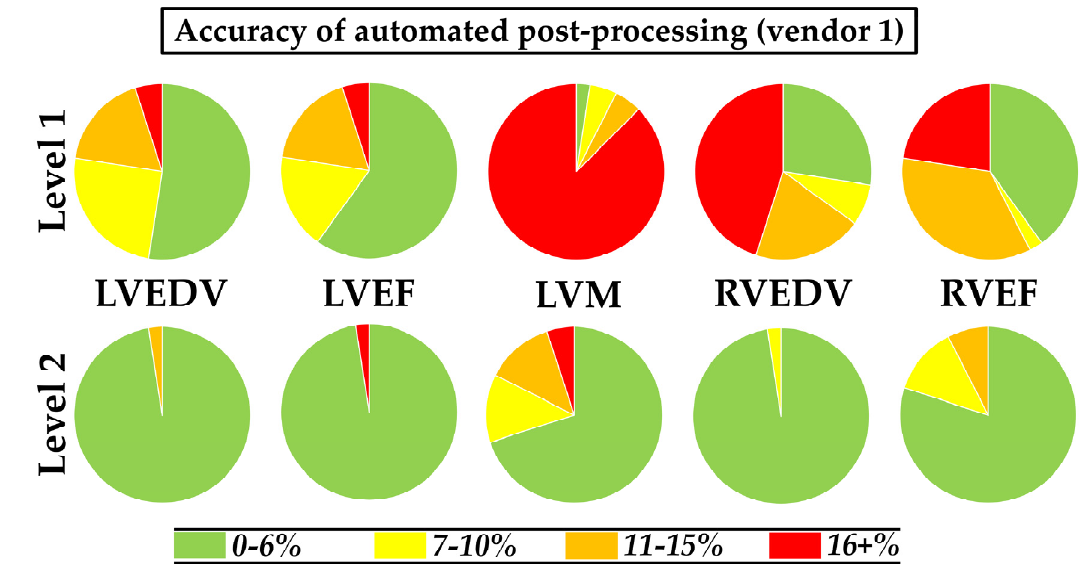
Figure 4. Accuracy of Level 1 and Level 2 automated post-processing results in vendor 1 compared to gold standard manual contour-tracing results. LV: left ventricle; EDV: end-diastolic volume; EF ejection fraction; M mass; RV: right ventricle.